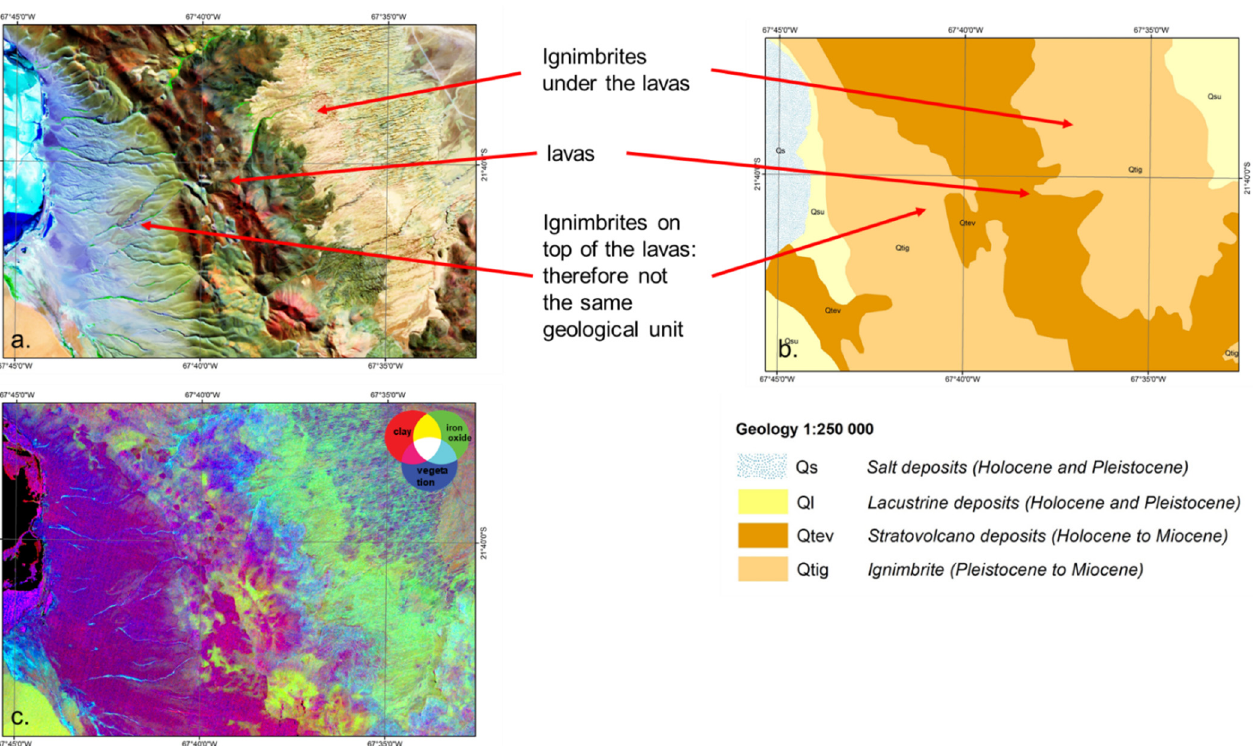
Figure 8. Geological interpretation aided with EO data over a portion of the study area. The general temporal relationship is indicated by the legend (Qs, youngest, to Qtig, oldest; see Appendix A for details); however, the geological interpretation shows that multiple instances and ages of Qtig (ignimbrite) occur, including relatively young ignimbrite deposits (western part of the map) and relatively old ignimbrite deposits (eastern part of the image), separated by an intervening unit of stratovolcano deposits. ( a ) Landsat-8 RGB colour composite topographically shaded; ( b ) geological map; ( c ) Abrams ASTER ratio .